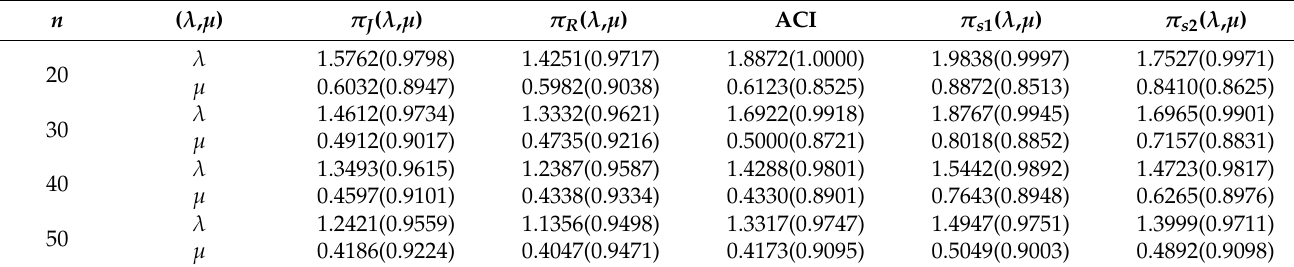
Table 5. The WCIs and CPs (within bracket) of parameters in case